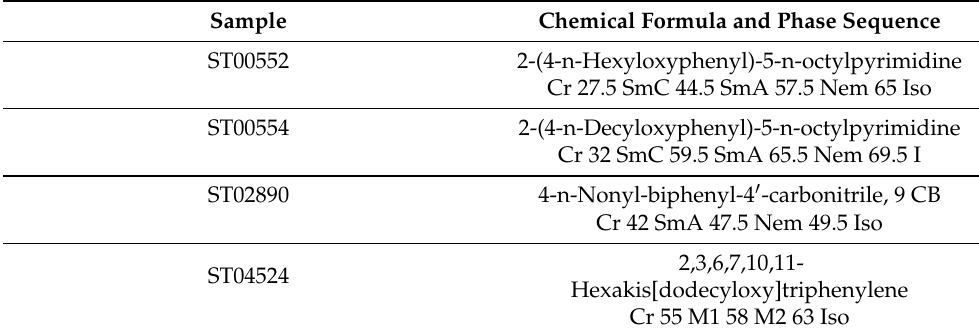
Table 2. Chemical compositions and phase sequences of the materials that were used in the micro- gravity experiments. The transition temperatures are given in ◦ C. The mesophases are labeled as SmC (smectic C), SmA (smectic A) and Nem (nematic). M1 and M2 represent modulated smectic phases